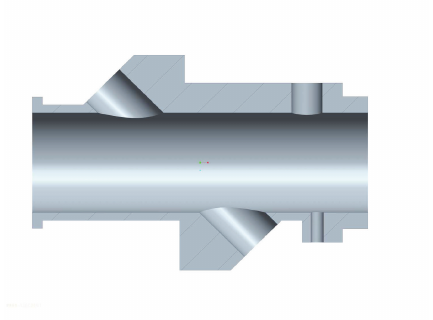
Figure 2: The velocity profile in the laminar flow.